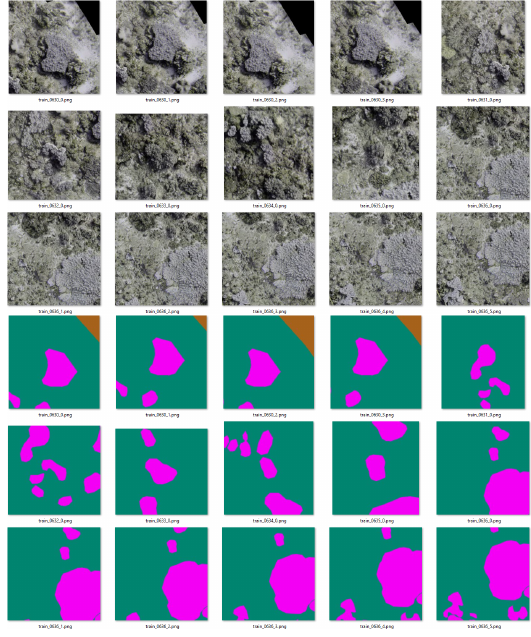
Figure 3. An excerpt of the dataset after the coral oversampling. (Top) RGB images. (Bottom) Corresponding